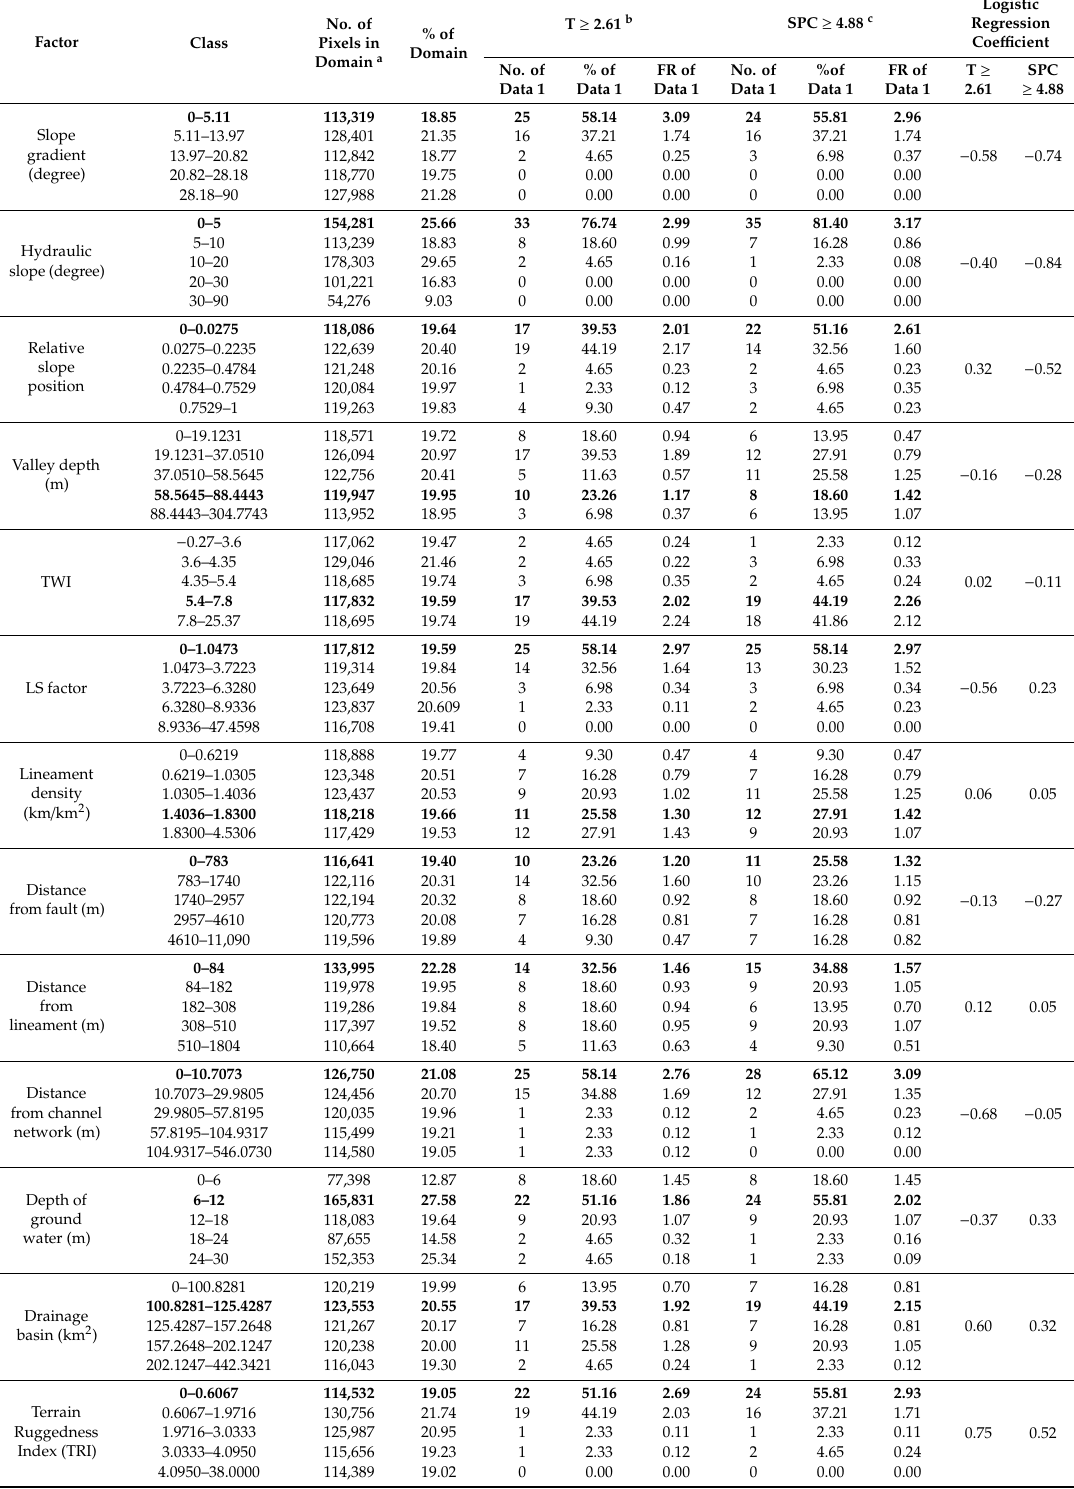
Table 3. Frequency ratio and logistic regression (LR) model’s results between groundwater productivity data and related